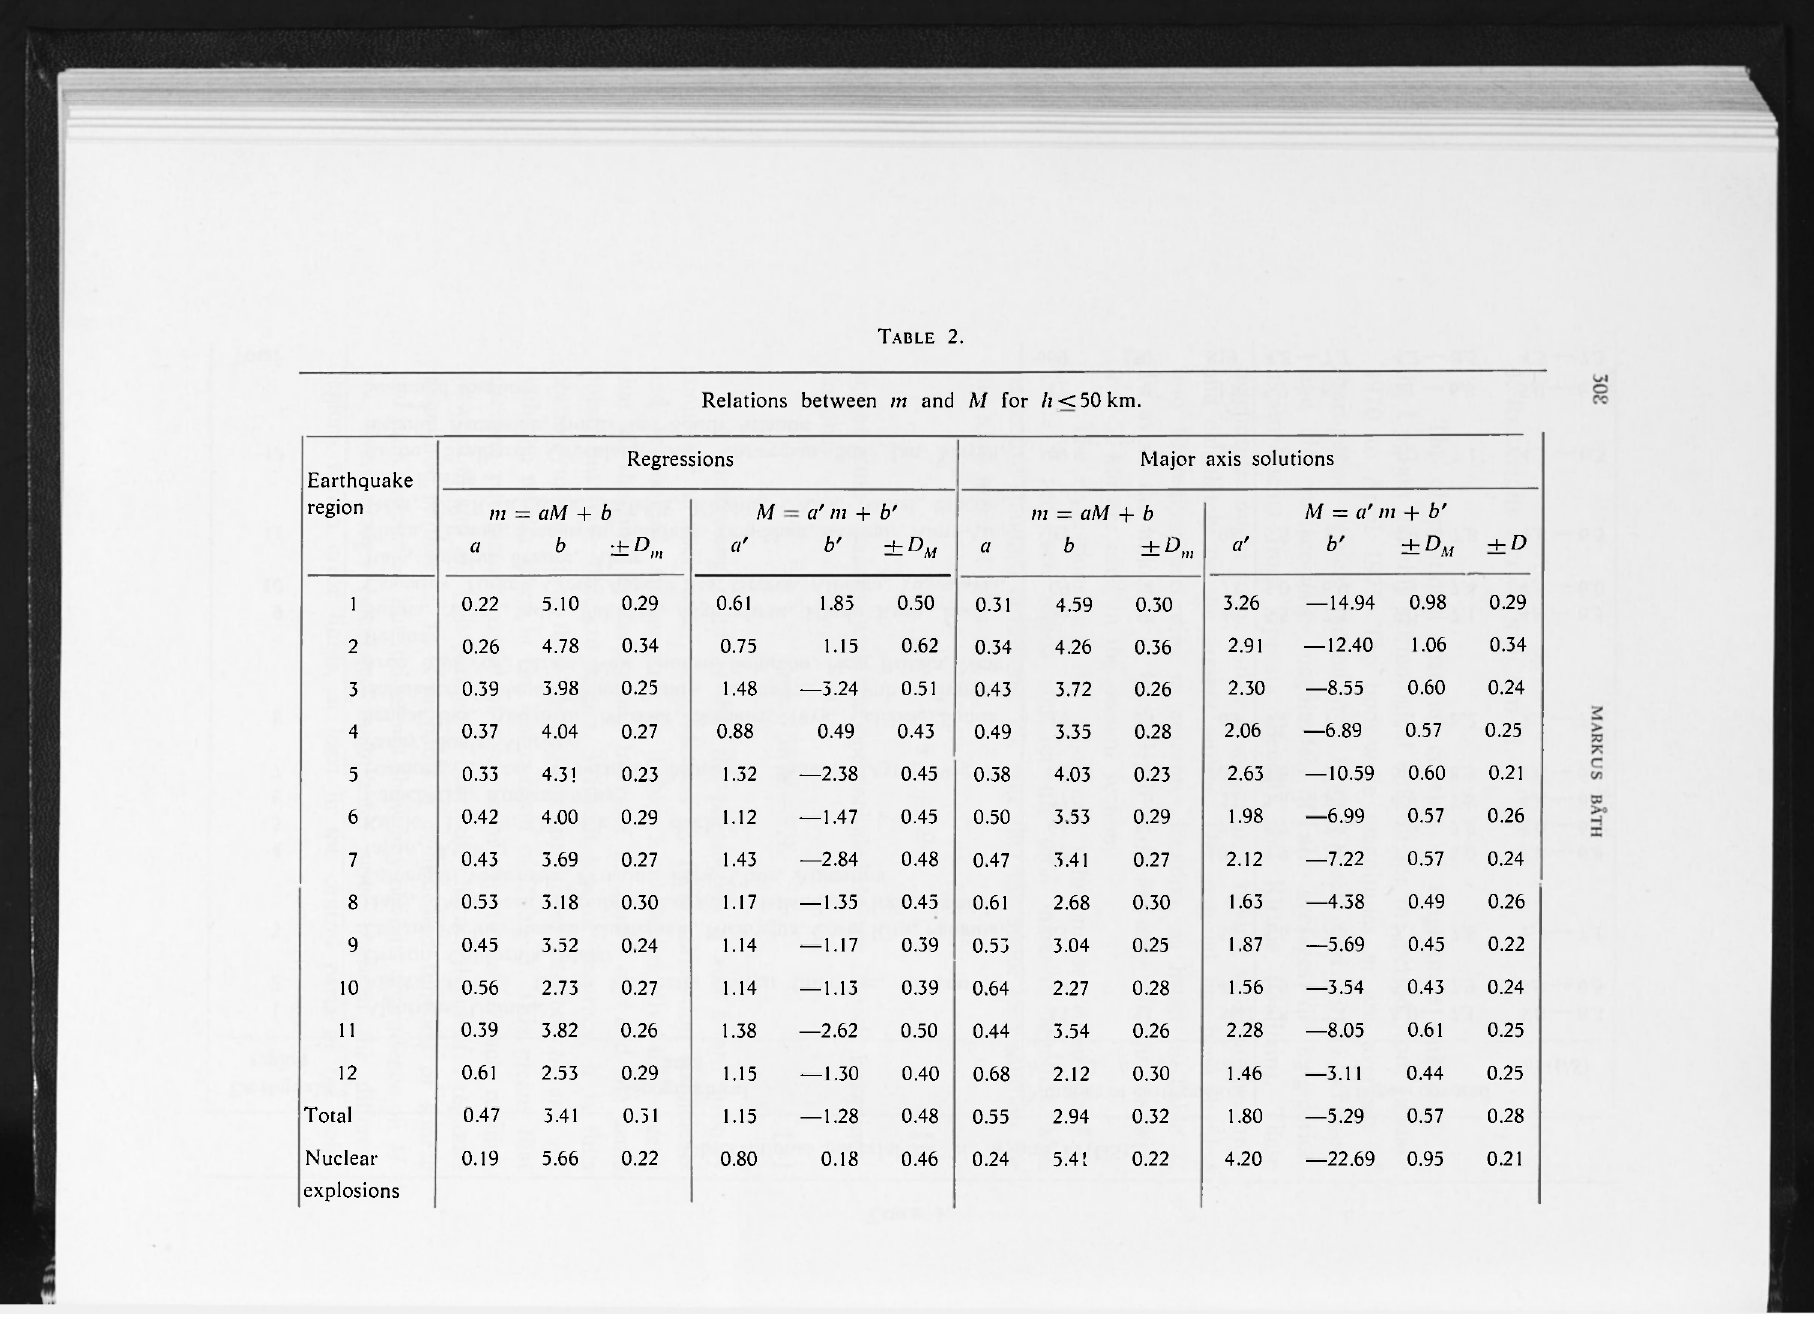
Relations between m and M for h <50